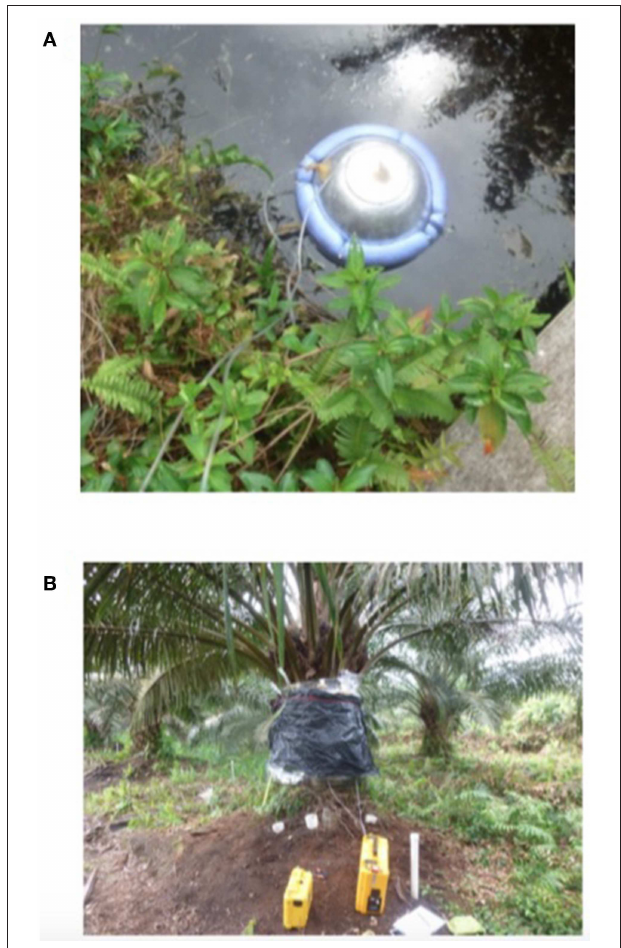
FIGURE 2 | Chambers adapted for this study: (A) a floating chamber to measure CO 2 and CH 4 fluxes from the drainage ditches, and (B) a novel stem chamber to measure stem CO 2 and CH 4